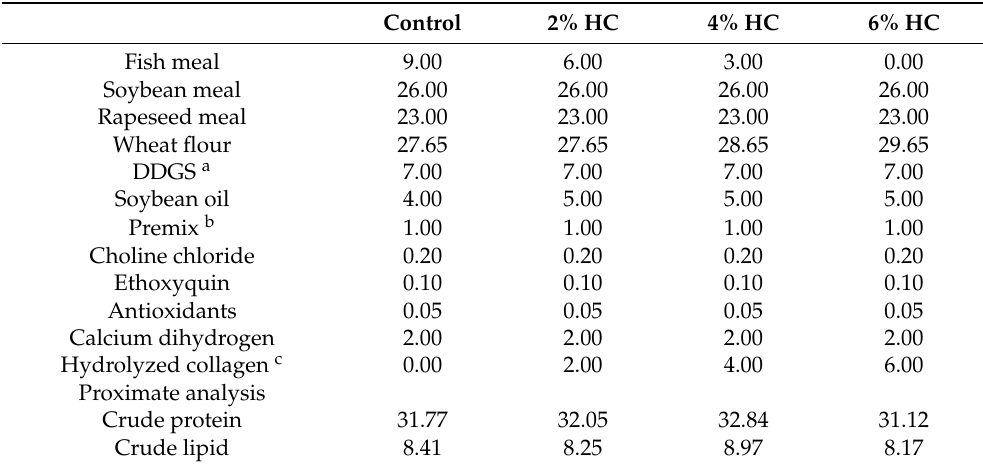
Table 1. Formulation and proximate analysis of experimental diets (% dry matter).